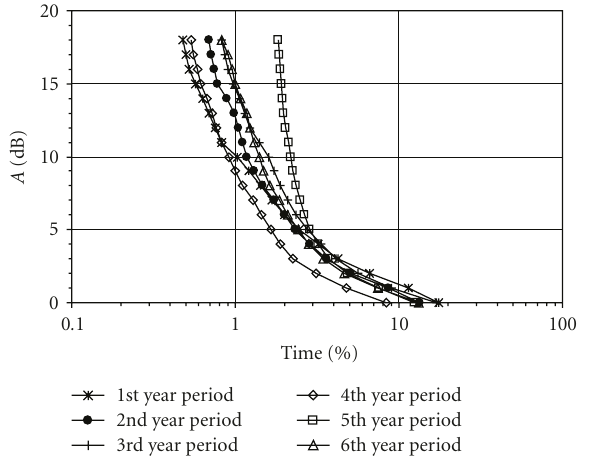
Figure 6: Obtained CDs of attenuation due to all the hydrometeors combined and the individual hydrometeors separately on the FSO path over the 6-year period of observation.